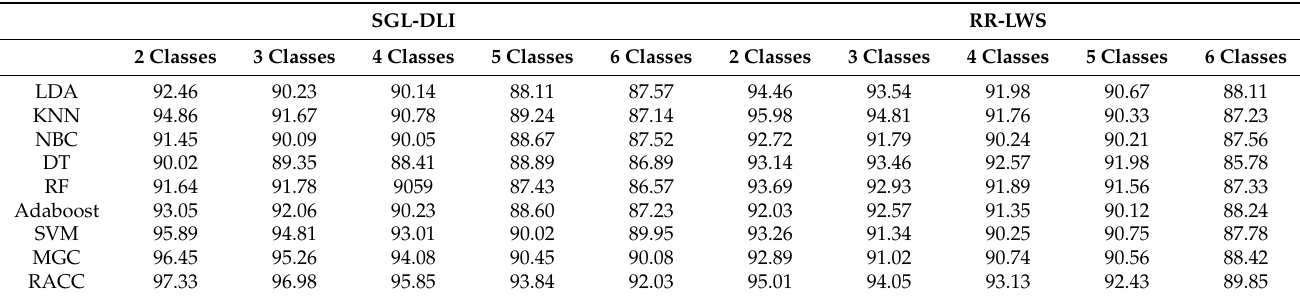
Table 7. Subspace clustering with VBMF.